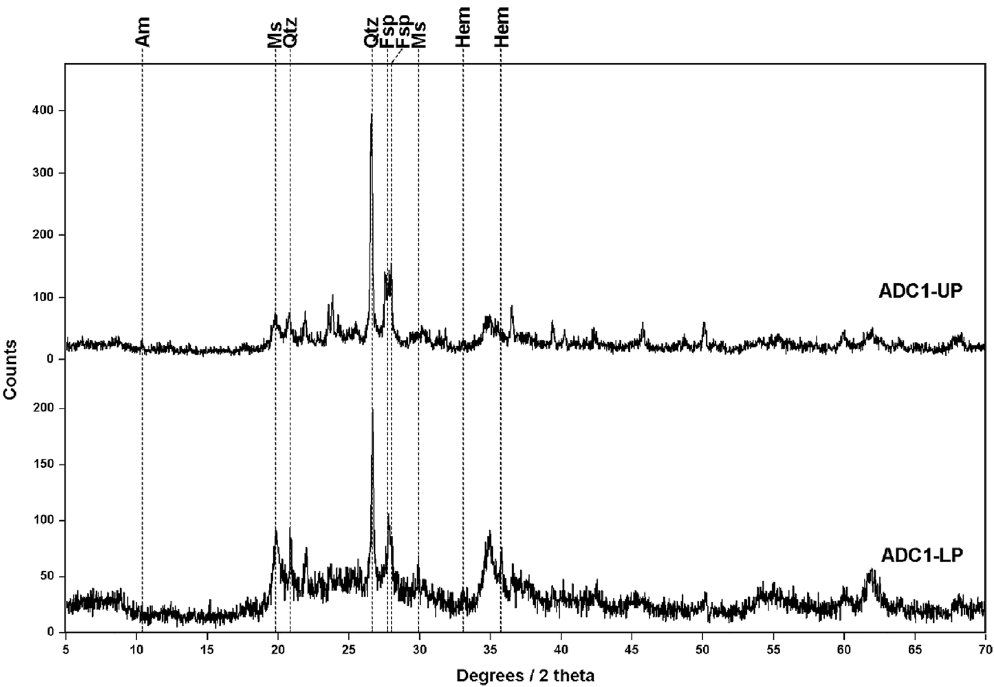
Figure 6. Diffractograms obtained from the analysis of samples ADC1-UP and -LP, revealing the presence of amphibole (Am, RUFF proxy ID: R110203), muscovite (Ms, R040104), quartz (Qtz, R040031), feldspar (Fsp, R040068) and hematite (Hem,